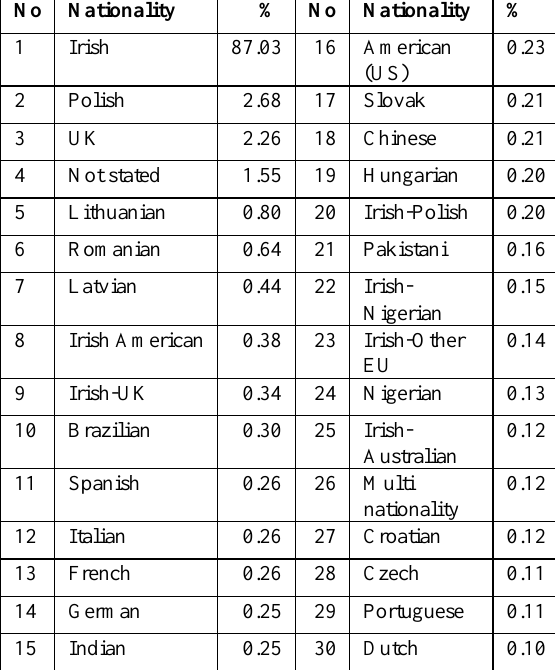
Table 2: Immigrant Background Based on CSO Data